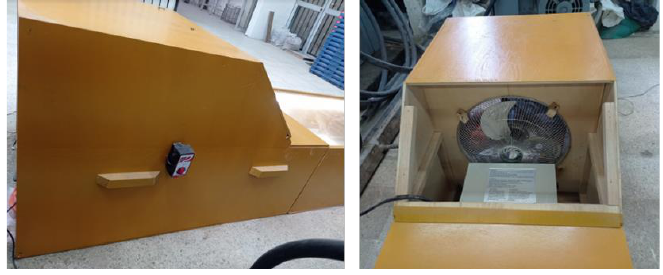
Figure 3. Block 1. Figure 3. Block 1.